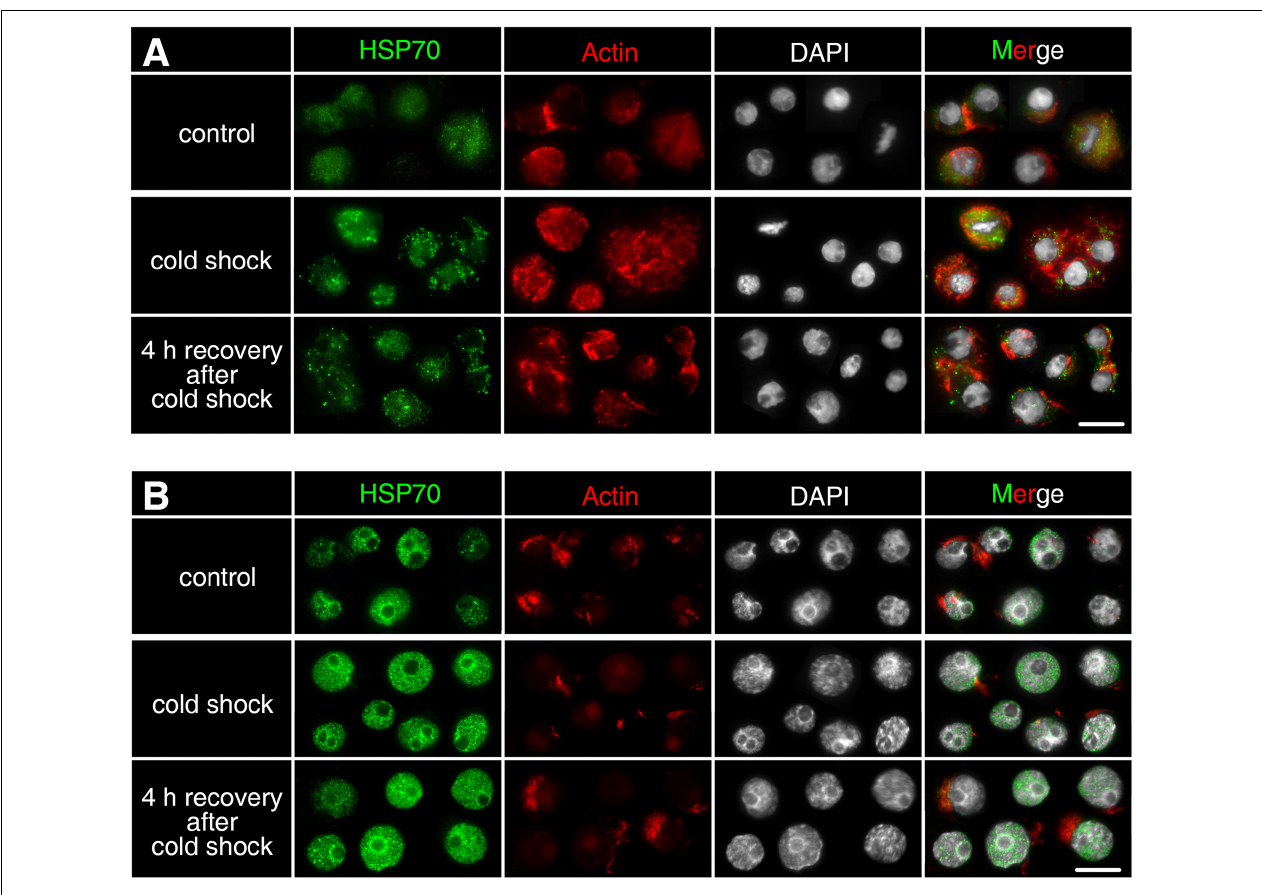
FIGURE 7 | Subcellular localization of HSP70B protein upon cold shock in developing cells from D. magna asexually produced embryos (A) and diapausing cells from D. magna sexually produced embryos (B) . Actin microfilament networks were stained with phalloidin in red and chromatin with DAPI in white. One-hour cold shock at 3 ± 0.1 ◦ C or –20 ± 0.1 ◦ C did not induce distribution changes of HSP70B (green) in (A) developing cells or (B) diapausing cells. Scale bars = 10 µ m.